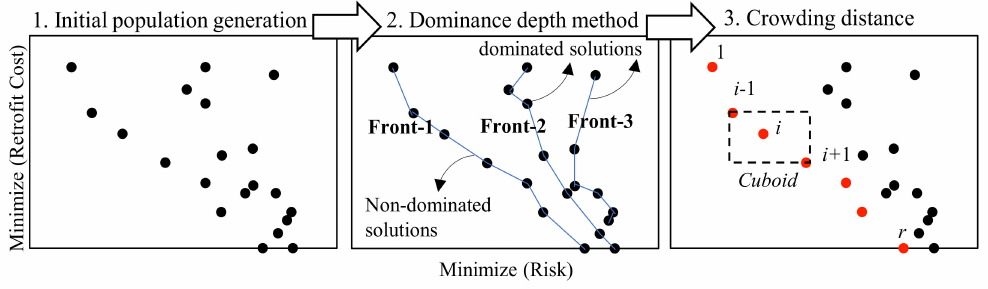
Figure 5. Illustration of fast non-dominated sorting and crowding